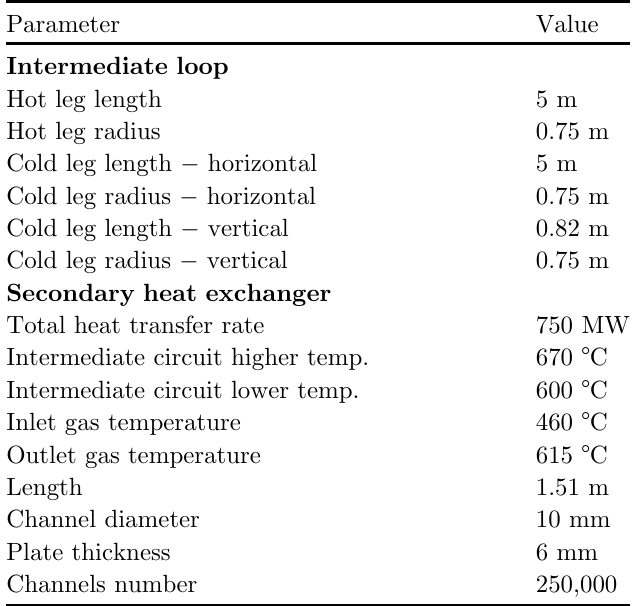
Table 4. Geometric and operational parameters of the SHX.